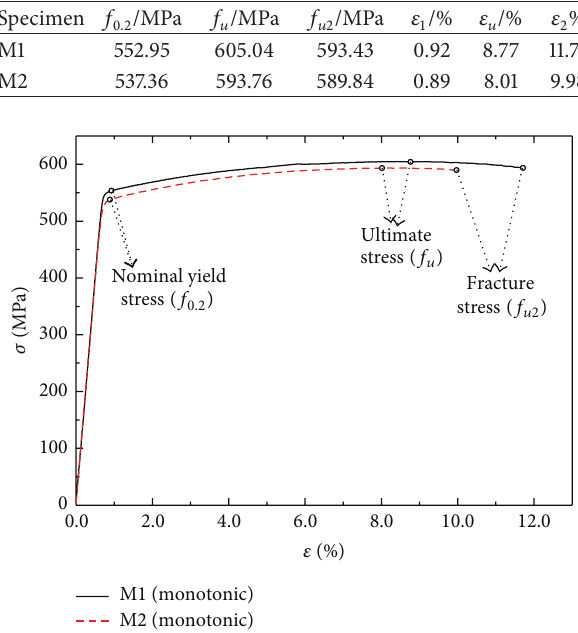
Table 2: Test results of monotonic loading.